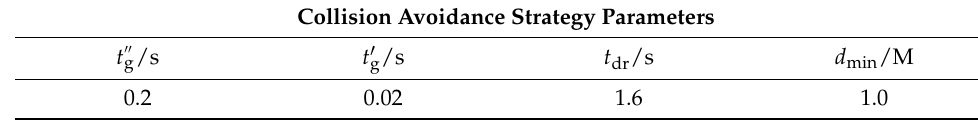
Figure 5. Matlab/Simulink Simulation model. Table 3. Specific collision avoidance strategy